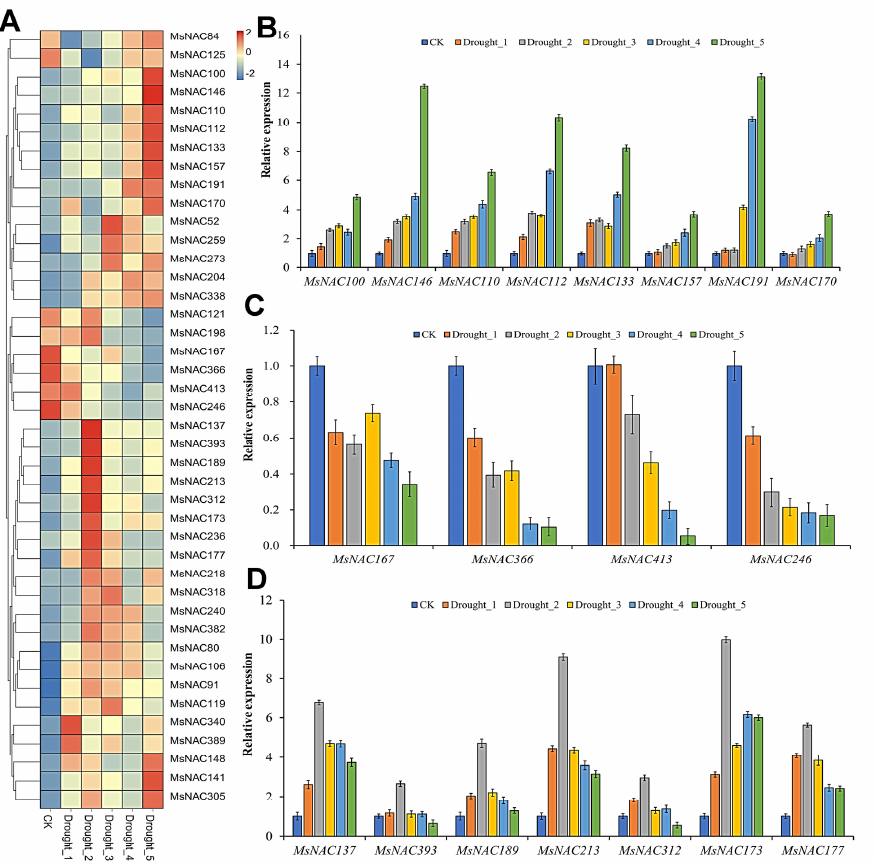
Figure 7. MsNAC genes that respond to drought stress. ( A ), Heatmap of the 42 MsNAC genes that respond to drought stress. The expression levels were normalized by row using the Z-Scores algorithm. The color scale at the right of the heatmap refers to the relative expression level, and the color gradient from blue to red presents an increasing expression level. ( B ), RT–PCR of MsNAC100 , MsNAC146 , MsNAC110 , MsNAC112 , MsNAC133 , MsNAC157 , MsNAC191 and MsNAC170 . ( C ), RT– PCR of MsNAC167 , MsNAC366 , MsNAC413 and MsNAC246 . ( D ), RT–PCR of MsNAC137 , MsNAC393 , MsNAC189 , MsNAC213 , MsNAC312 , MsNAC173 and MsNAC177 . CK was arbitrarily set to 1. Error bars represent the standard deviations of three technical